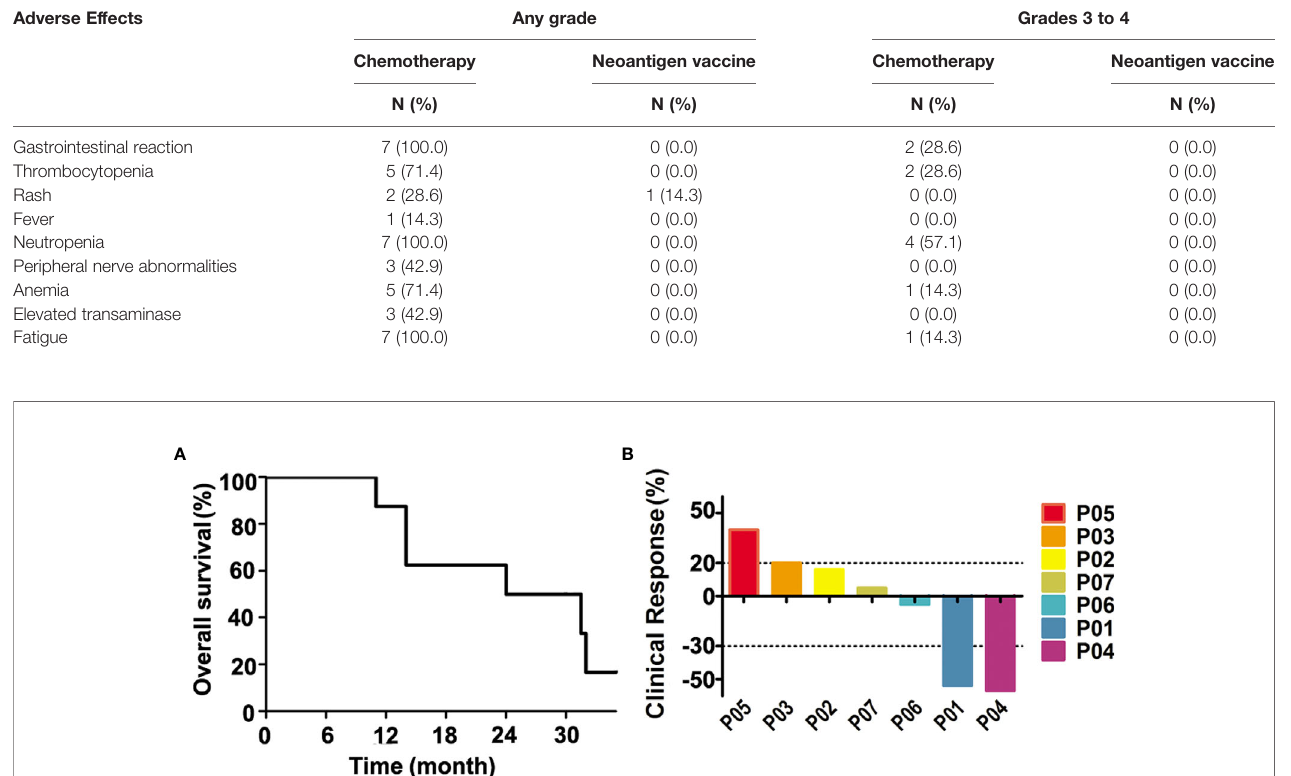
FIGURE 2 | The clinical response and prognosis of treated patients. (A) The overall survival curve of each patient. (B) The percentage changes of tumor lesion in size from baseline. The changes in lesions between a positive value of 25% and a negative value of 50% are considered stable disease.